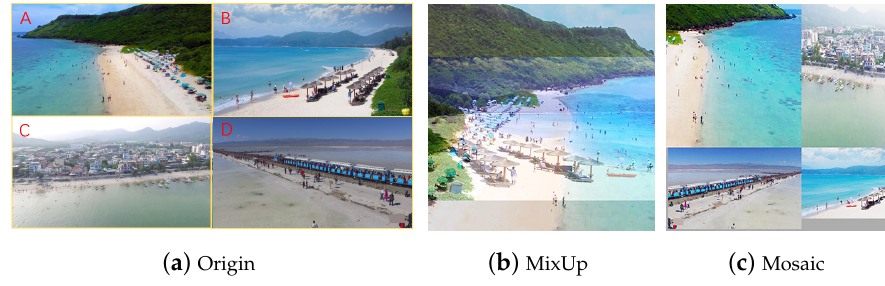
Figure 2. Results of different data augmentation